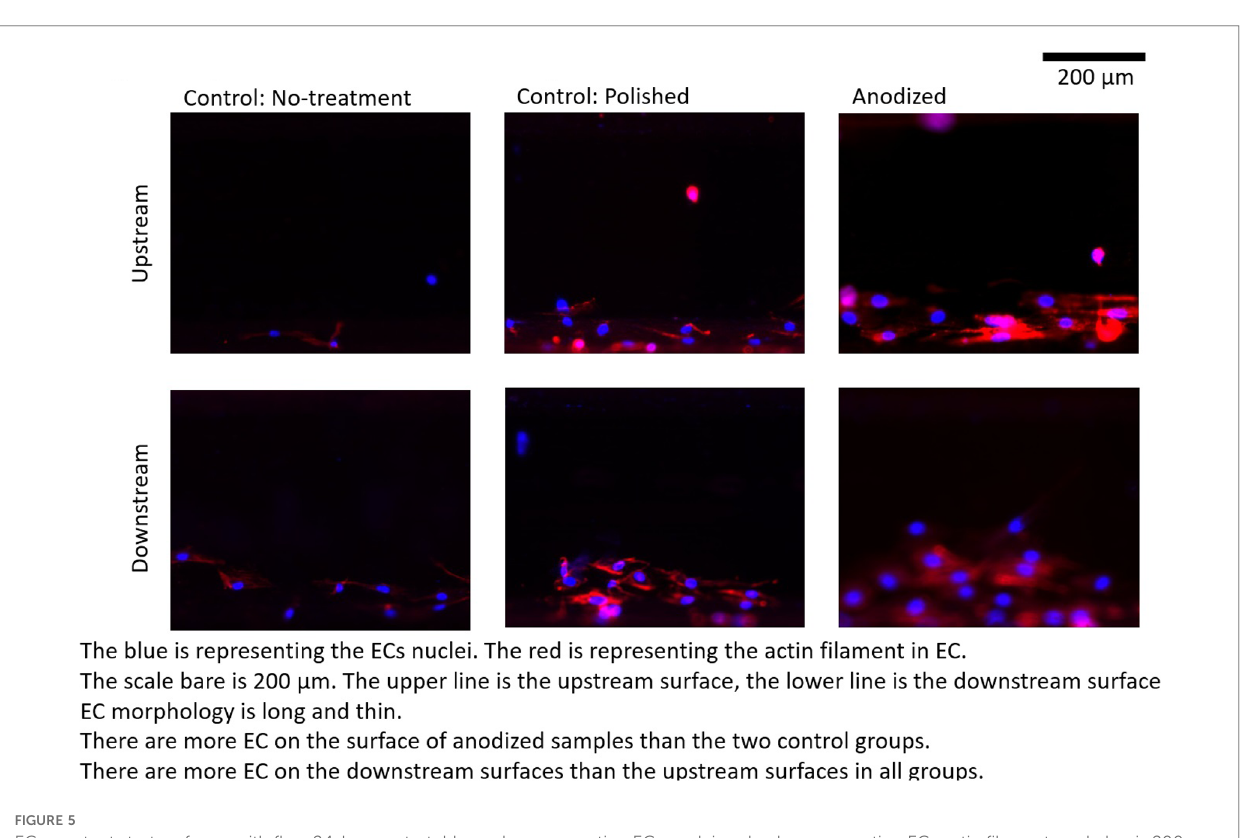
FIGURE 5 ECs on stent strut surfaces, with fl ow 24-h, one strut; blue color representing ECs nuclei; red color representing ECs actin fi lament; scale bar is 200 μ m.